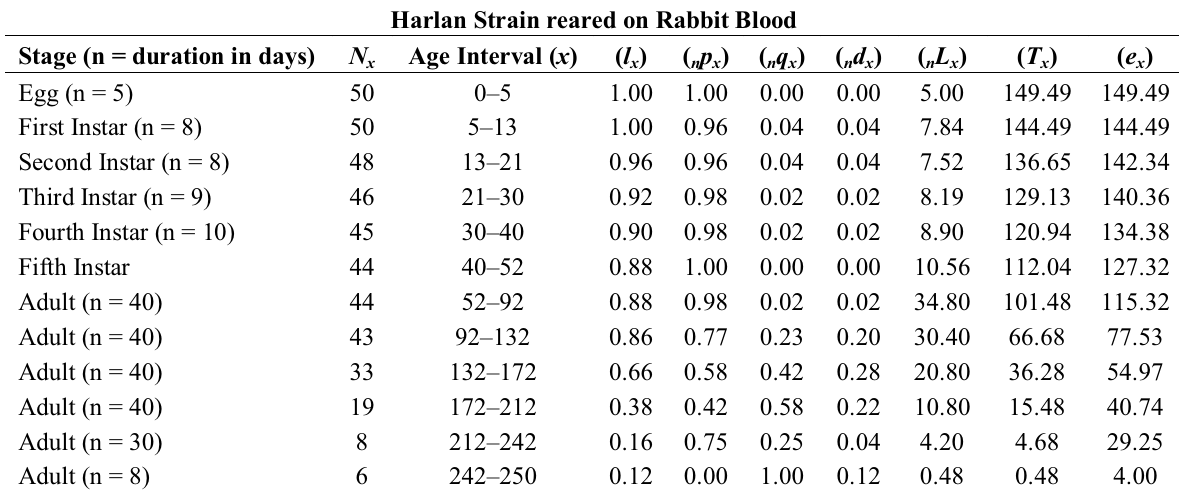
Table 4. Stage specific life table of Harlan strain Cimex lectularius on rabbit blood. Harlan Strain reared on Rabbit